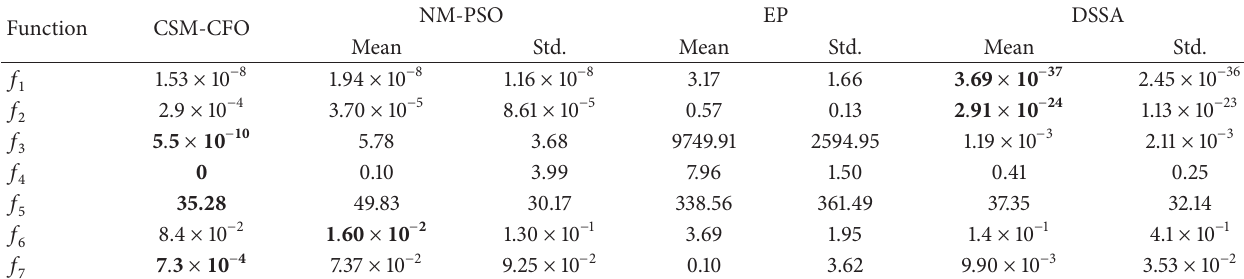
Table 4: Minimization result of benchmark functions in Table 1 with 𝑛 = 30 .